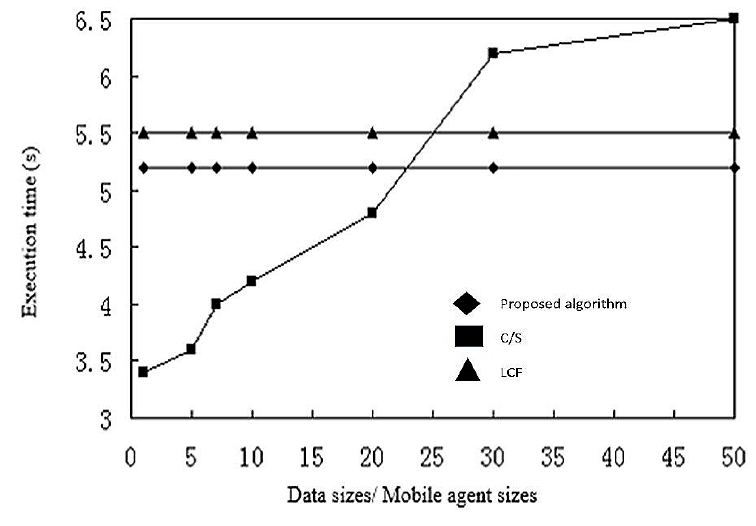
Figure 16. Execution time.